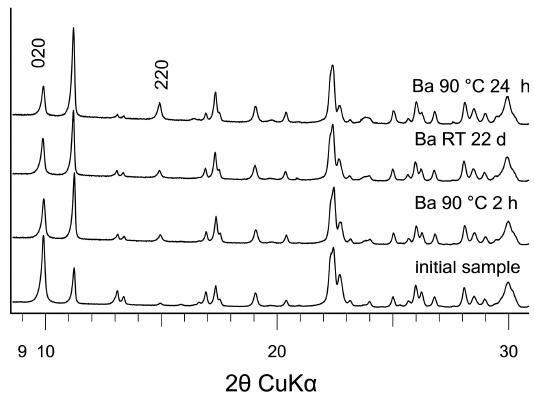
Figure 2. Selected powder XRD patterns of Ba-exchanged clinoptlolite.